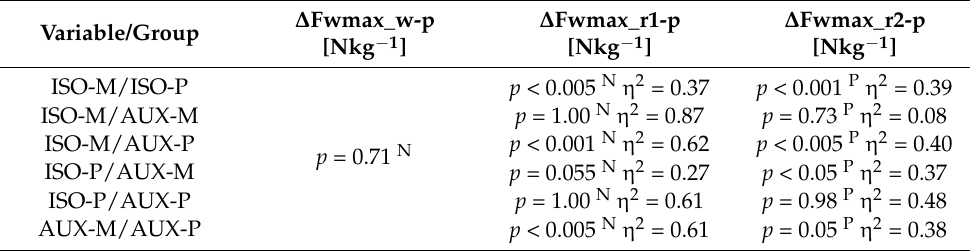
Table 4. Results of the analysis of variance ANOVA (F-test; Tukey’s post-hoc test) and its counterpart for non-parametric ANOVA Kruskal–Willis tests (Dunn’s post hoc test) of the changes in maximum relative strength compared to baseline in subsequent periods of the experiment between groups of participants.